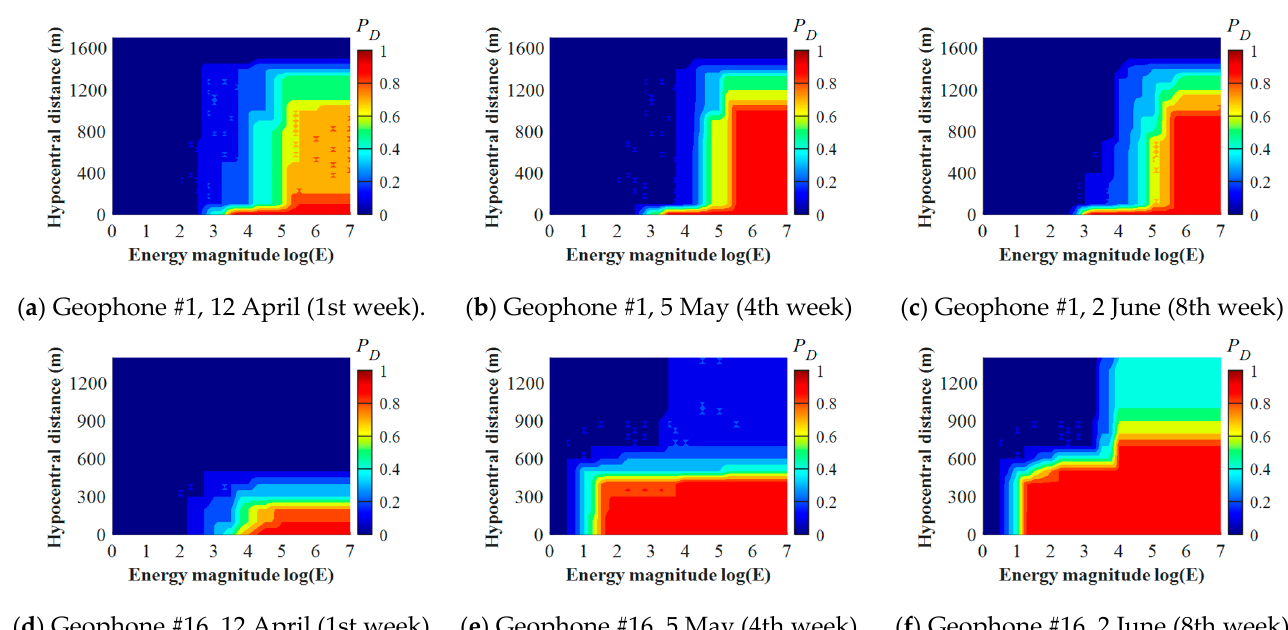
Figure 4. Evolution of Geophone #1 ( a – c ) and #16 ( d – f ) at different weeks. According to Section 2.3, 𝑃 (cid:3005)((cid:3039)(cid:3028)(cid:3046)(cid:3047)) of a geophone before relocation uses the most D ( last ) seismic recordings for 𝑃 (cid:3005) calculation, and it is regarded as having the highest reliability. Therefore, using Equation (6), the reliability of the 𝑃 (cid:3005) result of a geophone can be as- sessed by its similarity with its 𝑃 (cid:3005)((cid:3039)(cid:3028)(cid:3046)(cid:3047)) . Figure 5 shows the 𝑃 (cid:3005) similarities of the five available geophones in LW250105 for 12 April to 2 June 2014. For each geophone, the 𝑃 (cid:3005) similarity for a given time period is calculated by comparing it with the 𝑃 (cid:3005) result on 2 June 2014, which is the 𝑃 (cid:3005)((cid:3039)(cid:3028)(cid:3046)(cid:3047)) before the geophone movement on 5 June 2014. Figure 5 indicates significant differences of 𝑃 (cid:3005) similarities over the first three weeks between different geophones. On 12 April 2014, Geophone #1 had the best 𝑃 (cid:3005) results of the first week, which presented 91% similarity. In contrast, the 𝑃 (cid:3005) similarities of the other four